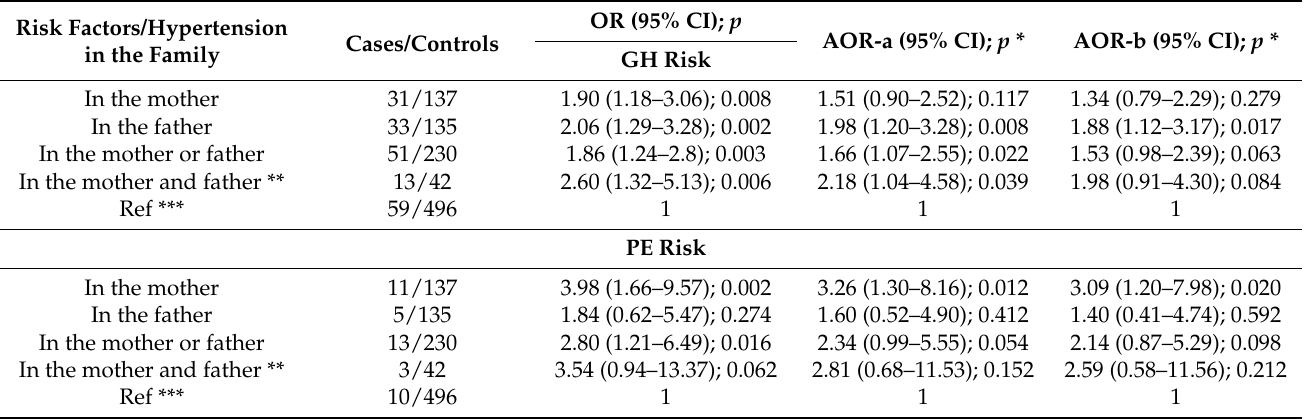
Table 4. Unadjusted and adjusted odds ratios for the association between paternal and maternal hypertension on gestational hypertension (GH) and preeclampsia (PE) in the whole cohort.